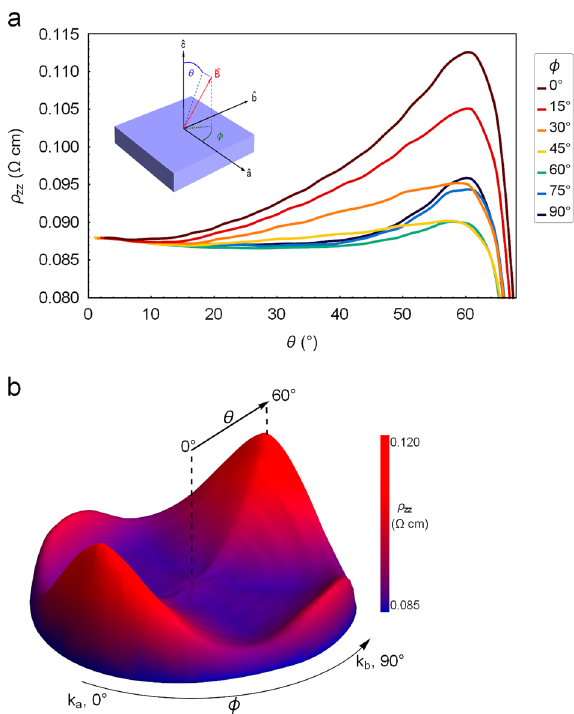
Fig. 1 The angle-dependent magnetoresistance of YBa 2 Cu 3 O 6.58 . The raw resistance ( a ) as a function of θ at 45 T and 15 K, for several ^ b -axis ( ϕ = 90°). values of ϕ spanning between the â-axis ( ϕ = 0°) and The rapid drop in resistivity beyond θ = 60° is due to the onset of superconductivity when insuf fi cient magnetic fi eld is parallel to the ĉ -axis. The inset de fi nes the fi eld angles ϕ and θ with respect to the ^ b , and ĉ axes. This data was taken at a crystallographic â, temperature of 15 K to increase the polar angular range over which the normal resistive state is accessed, 64 and to thermally suppress QOs. Broken C 4 symmetry is clearly shown in a polar plot of the data b , where the radius is the polar angle θ , and the amplitude and color correspond to the magnitude of the resistance